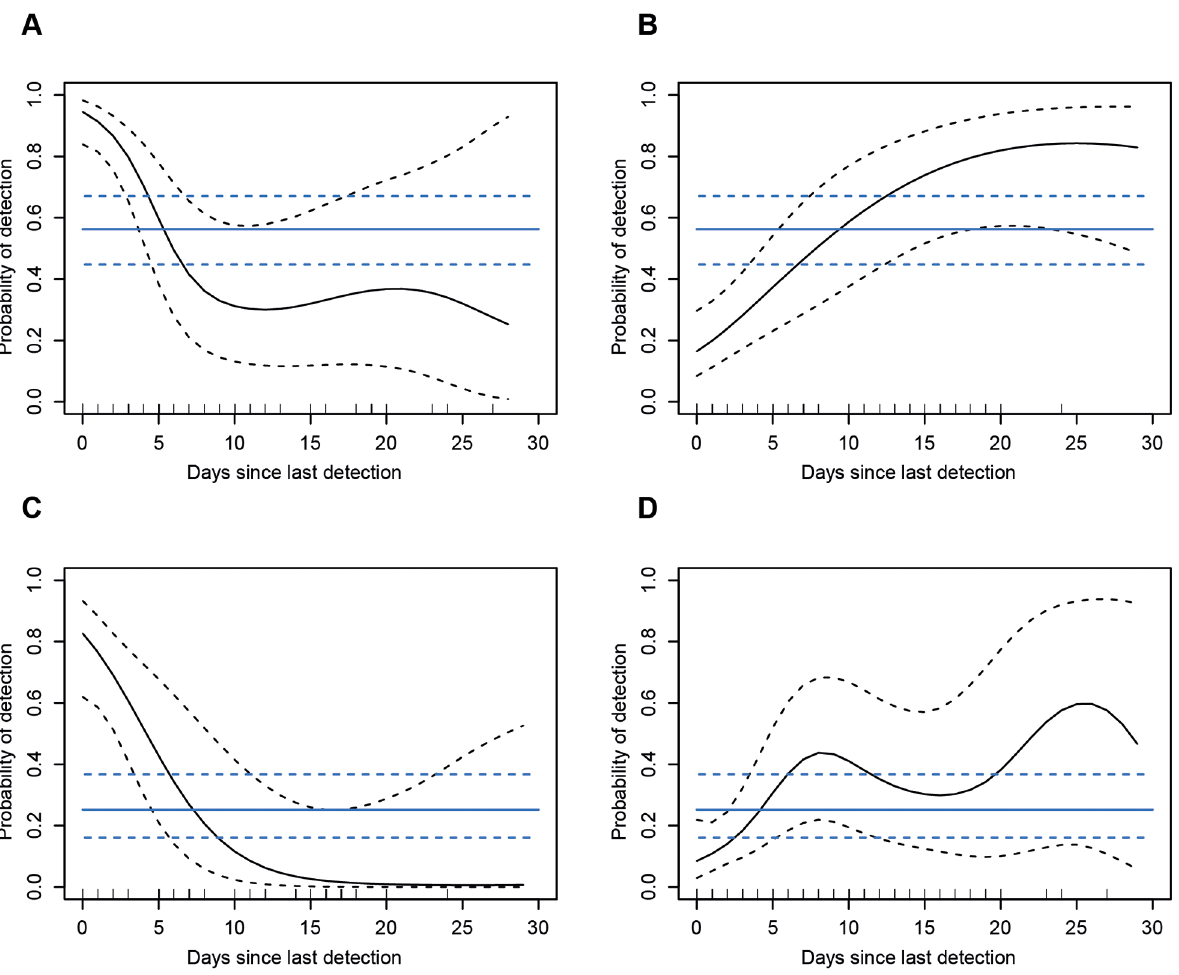
Figure 4. IAV detection probability for H1 and H3 Clades as a function of time and previously detected infections. The x-axis represents time in days since first detection of a virus. The y-axis depicts the probability of detection. Black continuous line represents the change over time in probability (95% CI with dashed lines). The horizontal blue line is the probability of detection of an infection with a virus from a specific clade for naı¨ve birds (95% CI with dashed lines). The distribution of data points is presented as rug plots along the x-axis. Detection probabilities for H1 (A) and H3 (C) Clades for individuals that have previously experienced an infection with a virus from the same clade. Detection probabilities for H1 (B) and H3 (D) Clades for individuals that have previously experienced an infection with a virus from another clade.